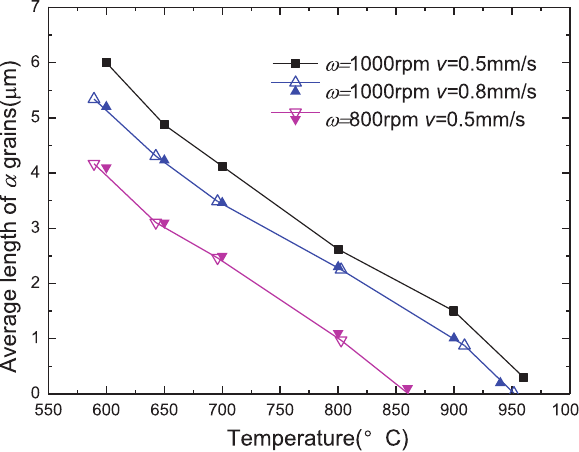
Figure 16: The average length of acicular α grains in different weld- ing